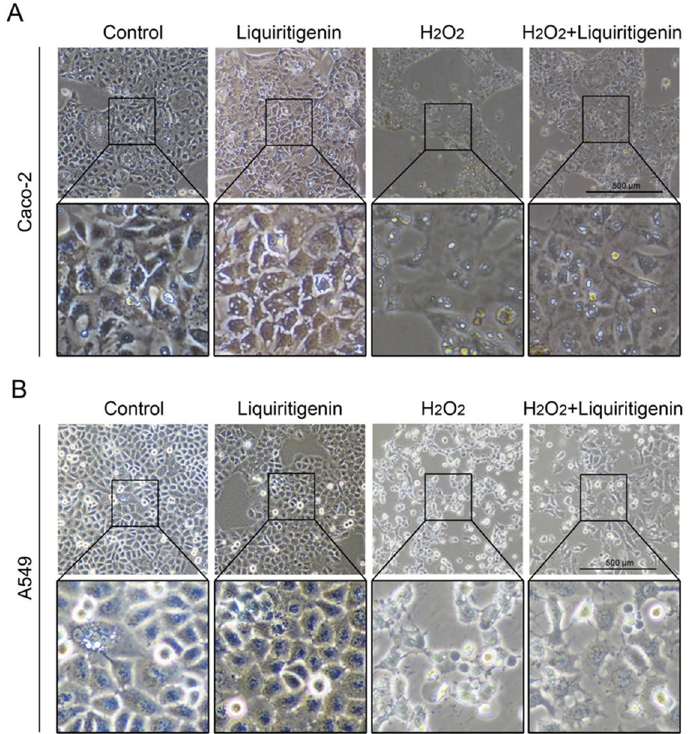
Figure 8. The variation of cell morphology observed under a light microscope in Caco-2 ( A ) and A549 ( B ) cells with liquiritigenin treatment against oxidative stress induced by H 2 O 2 .